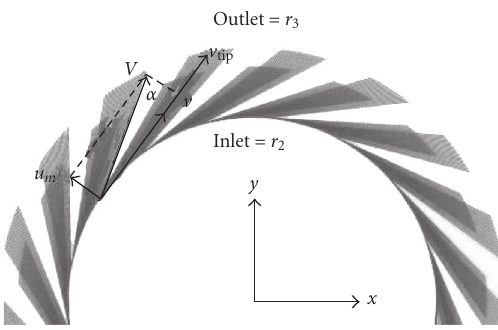
Figure 1: Di ff user model geometry and the boundary